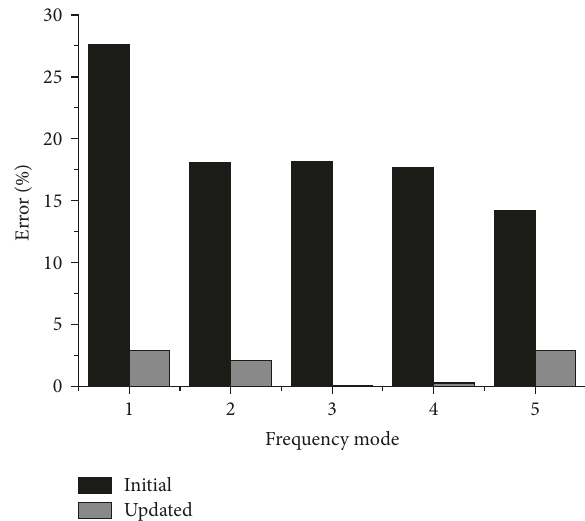
Figure 9: Errors of natural frequencies before and after